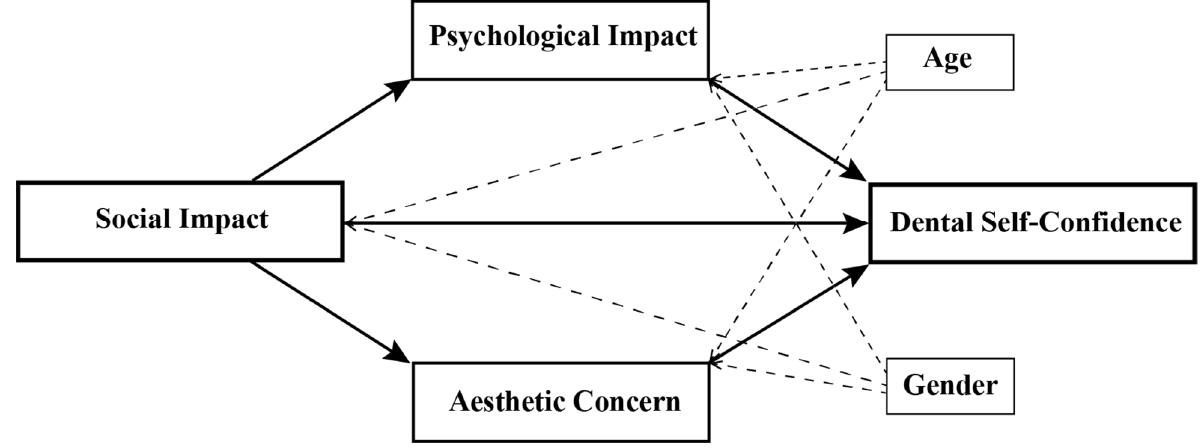
Figure 1. Hypothesis model.